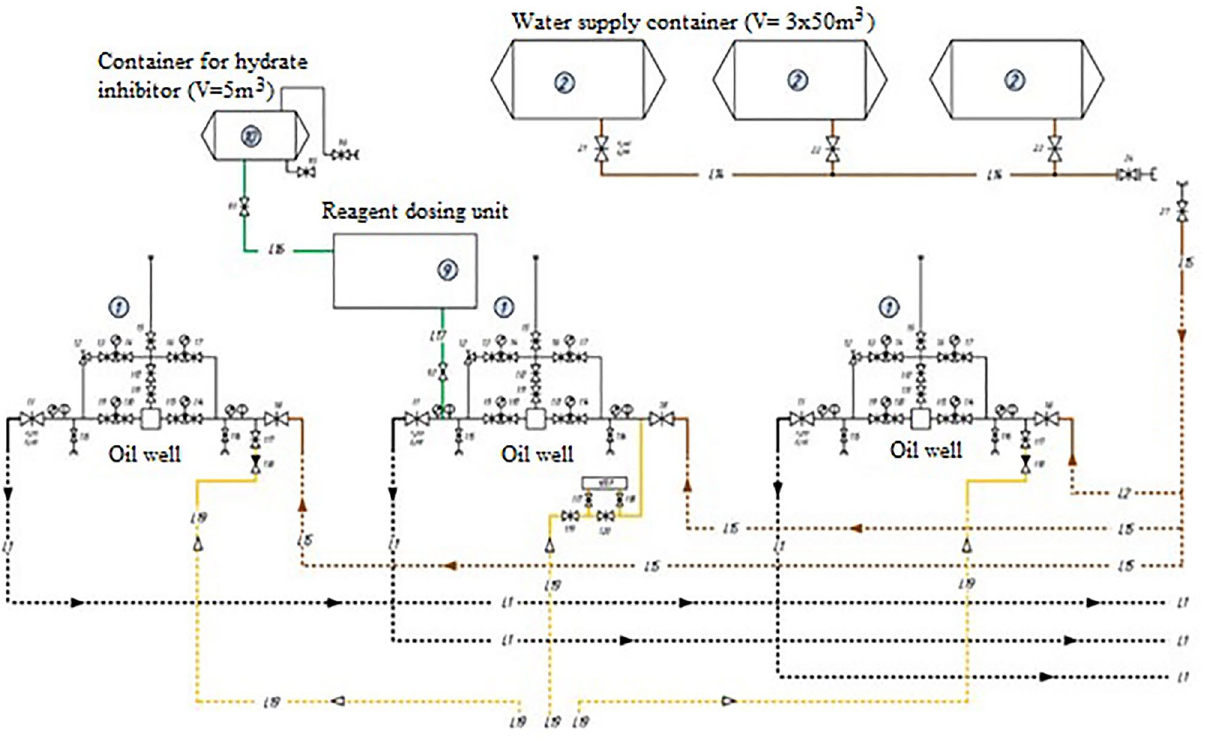
Figure 7. The existing scheme of automation of the technological